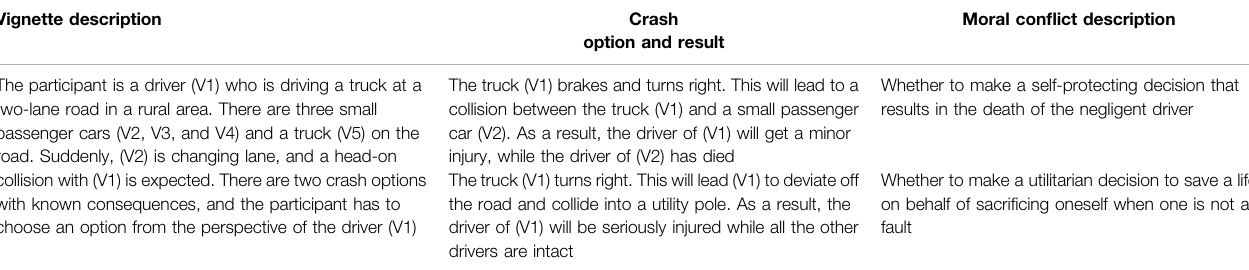
TABLE 1 | Characteristics of AV moral dilemma vignette (source: Rhim et al., 2020, p. 44). Vignette